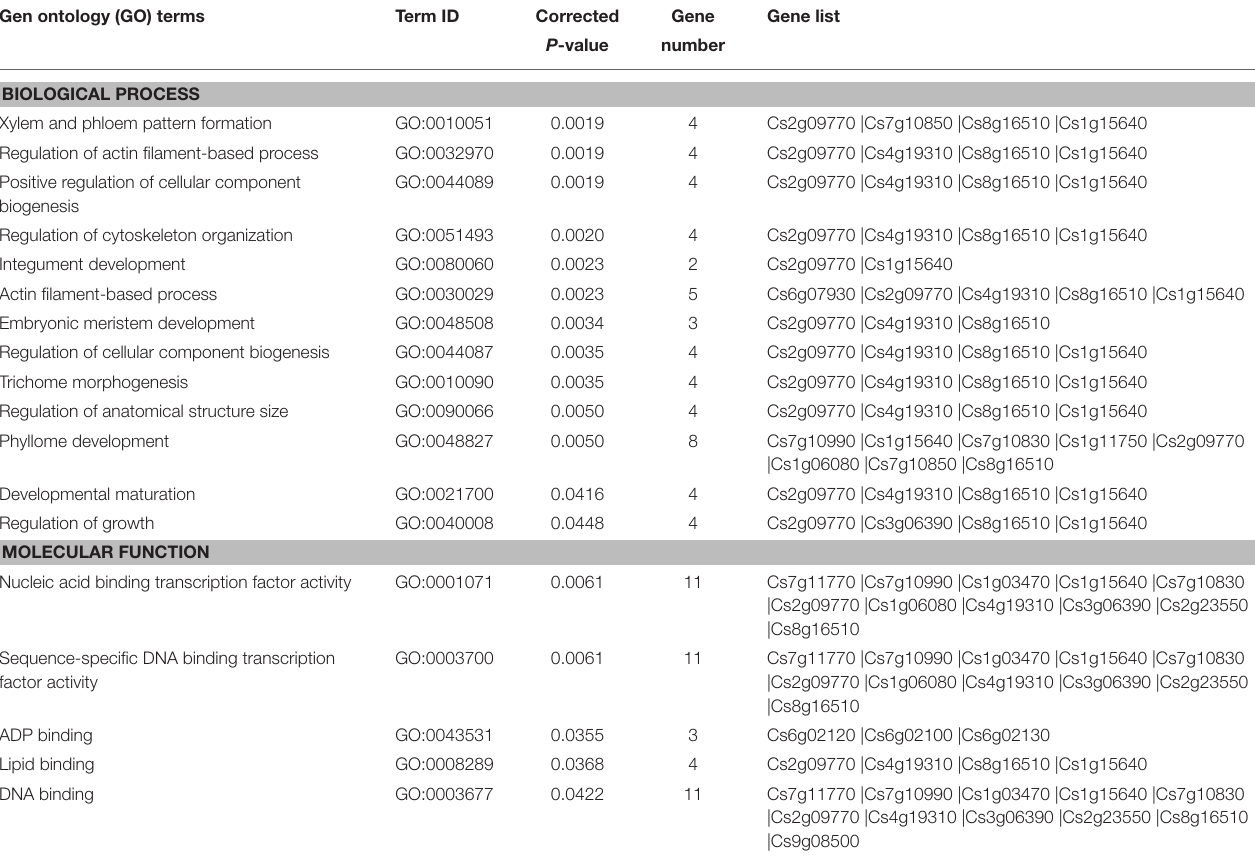
TABLE 4 | Gene Ontology enrichment analysis of the target genes of miRNAs differentially expressed between MT and